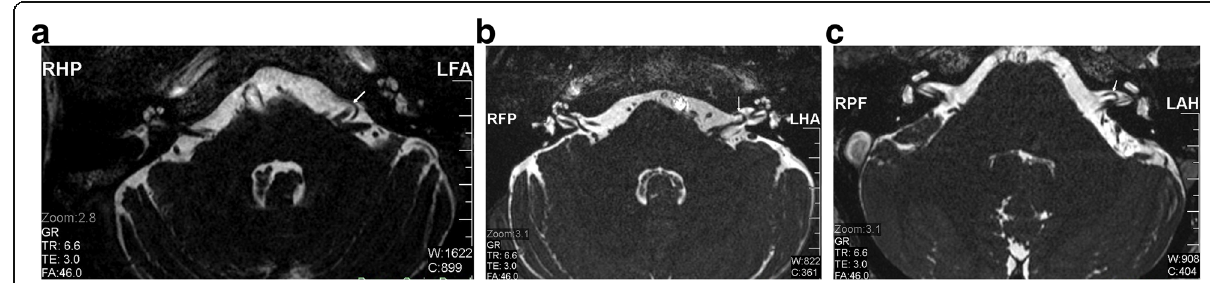
Fig. 1 Different grades of vascular loops in CISS images of the CPA and the IAC with white arrows pointing to the corresponding vascular loop. ( a ) grade I, ( b ) grade II, and ( c ) grade